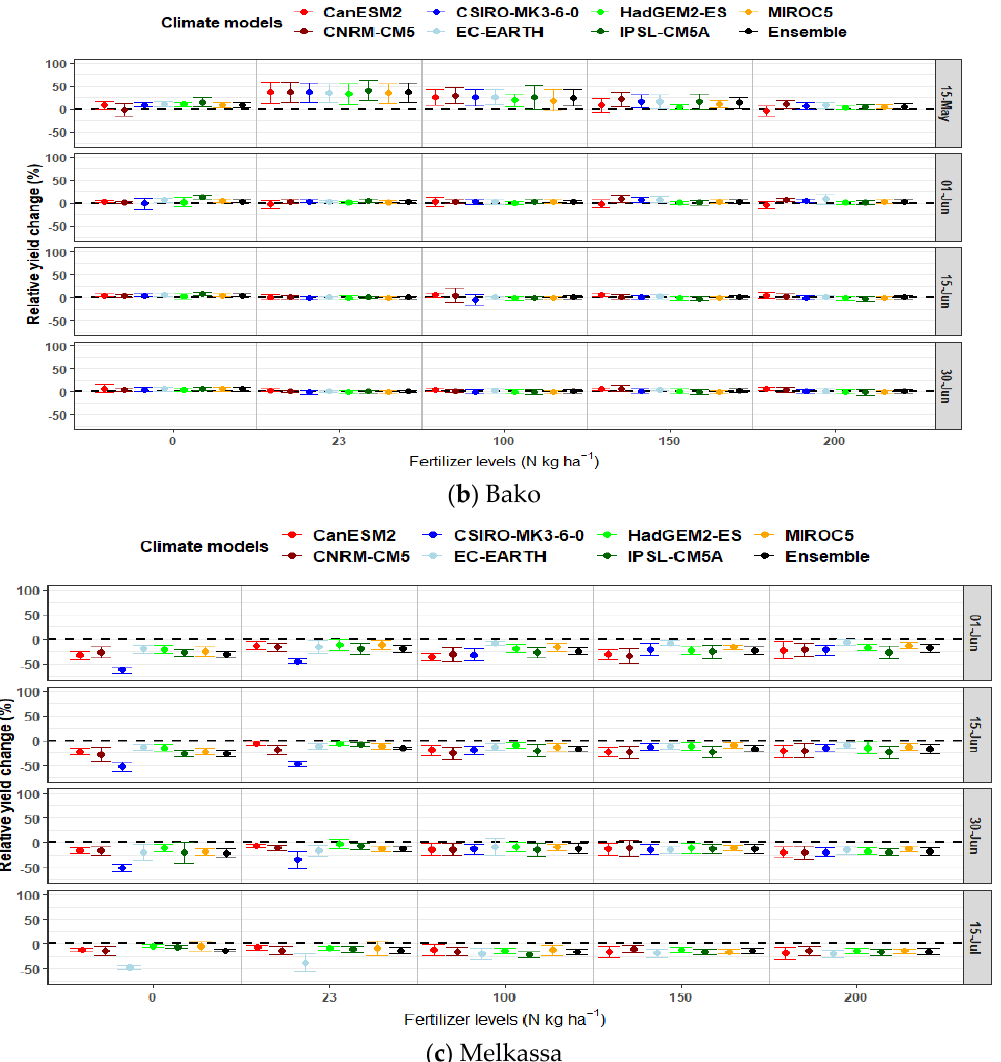
Figure 8. Climate model uncertainty in simulated mean maize yield (averaged for all cultivars) for different planting dates and nitrogen fertilizer levels for ( a ) Ambo (high altitude), ( b ) Bako (mid-altitude), and ( c ) Melkassa (low altitude). Error bars show the standard deviation of projected maize yield changes across the three crop models.